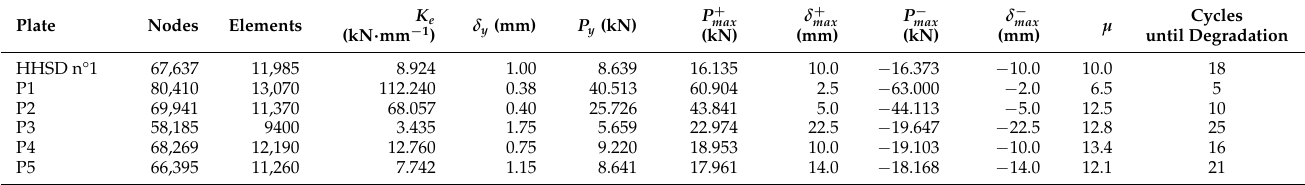
Table 3. Summary of finite element analysis